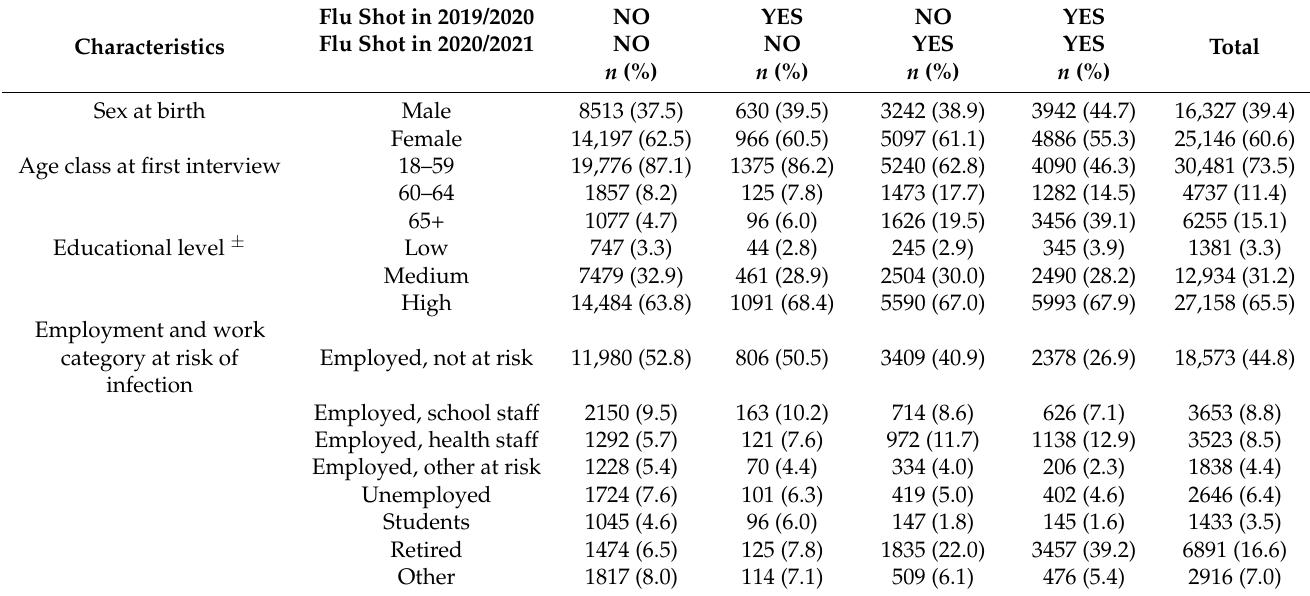
Table 1. Characteristics of the study population according to vaccine uptake during the 2019/2020 and 2020/2021 flu